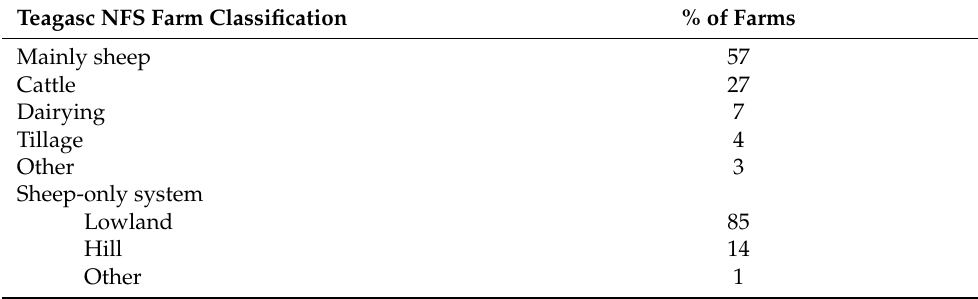
Table 3. Details of farm classification by main enterprise and sheep system ( n =